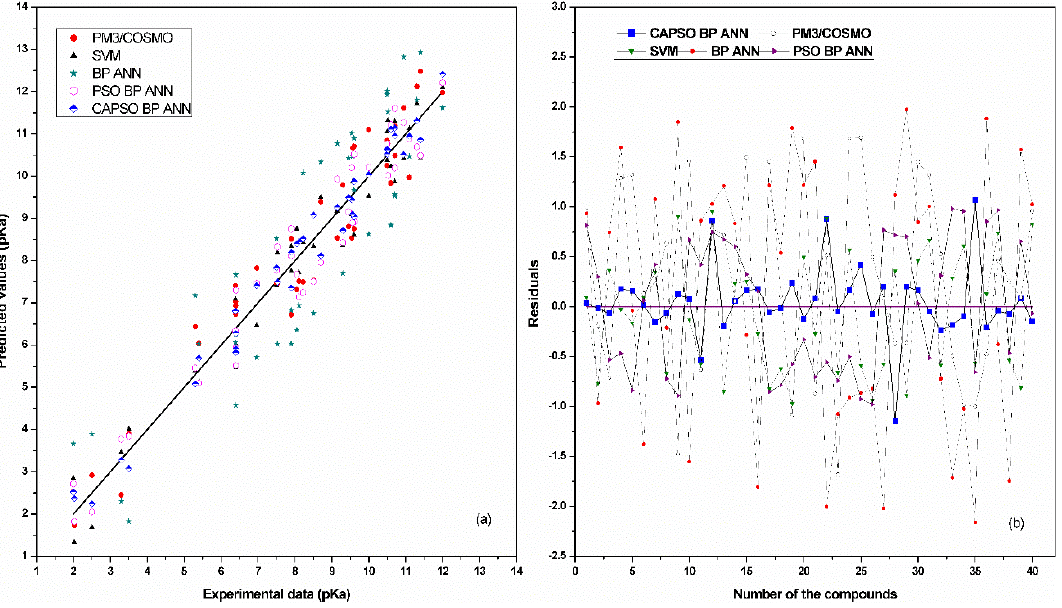
Figure 5. Comparison of the testing results of each model.